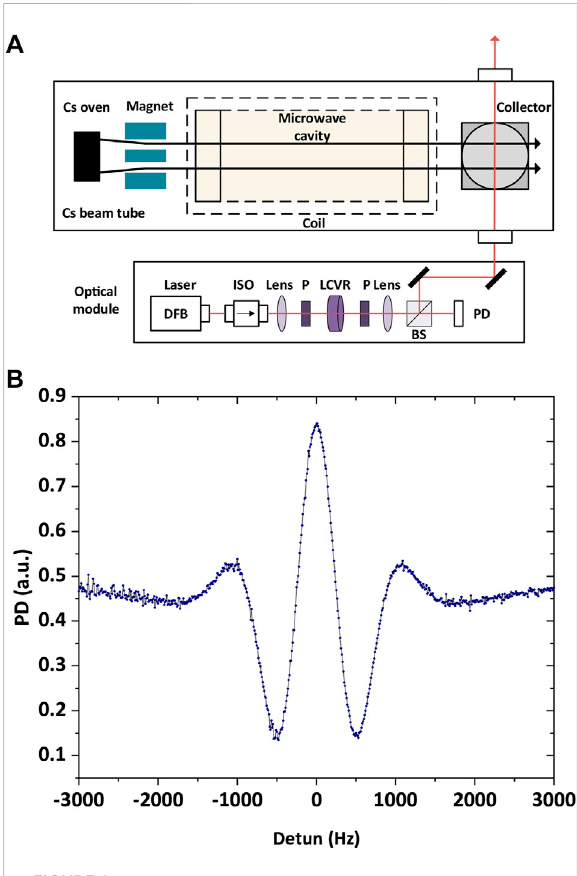
FIGURE 1 (A) Con fi guration of OMCC. ISO, Isolator; P, Polarizer; Lens, Convex lens; BS, Beam Splitter; PD, Photodiode; LCVR, Liquid crystal variable retarder. (B) Ramsey